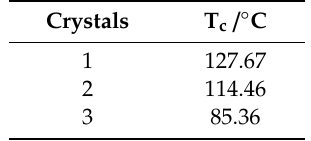
Table 2. DSC measurements.